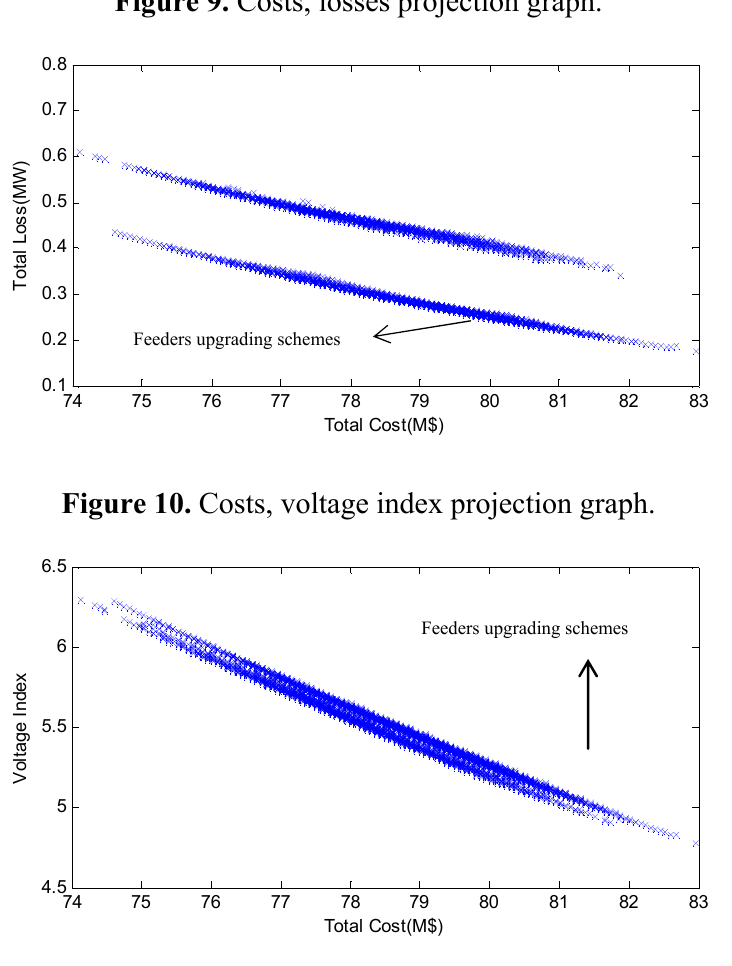
Figure 11. Losses, voltage index projection